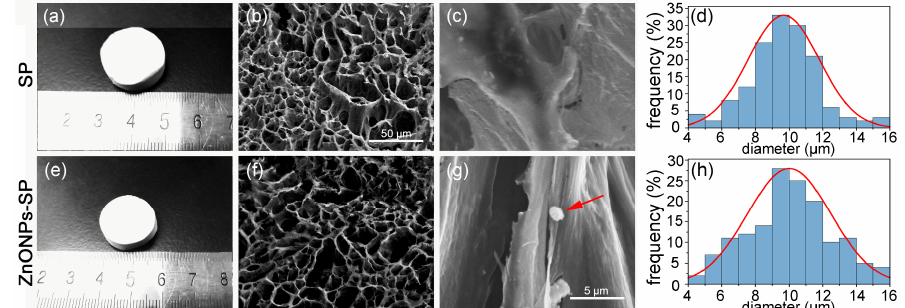
Figure 2. SEM. The pictures of SP sponge ( a ) and ZnONPs-SP sponge ( e ), SEM pictures of SP ( b , c ) and ZnONPs-SP ( f , g ). b , f , cross-section, c , g , longitudinal section, ( d , h ) the particle size analysis of SP and ZnONPs-SP, respectively. The red arrows indicated ZnONPs.